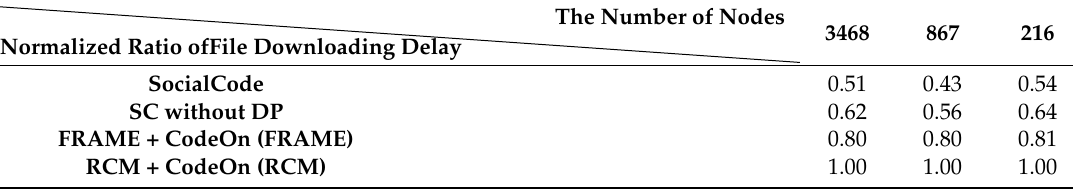
Table 6. Normalized ratios for average file downloading delays of SocialCode, SC without DP